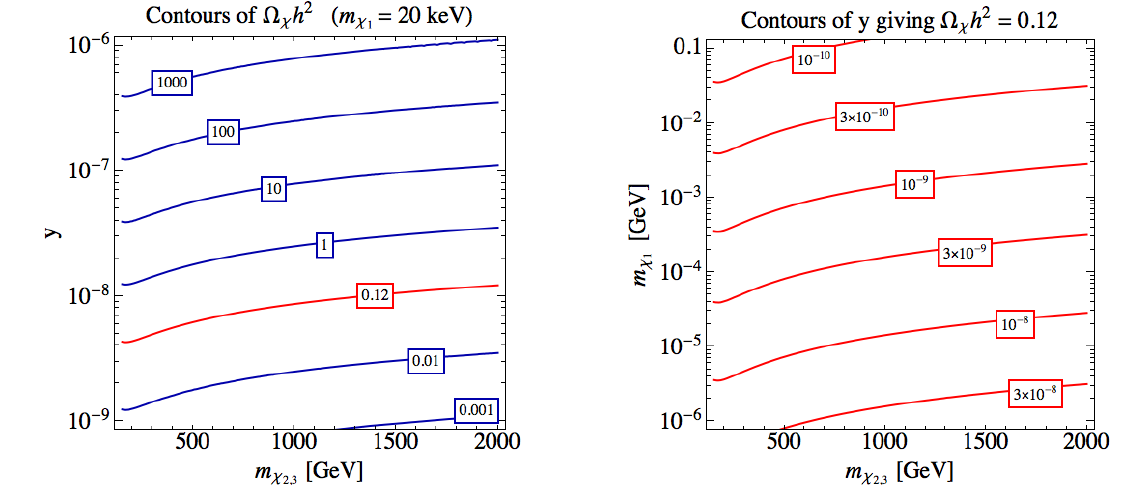
Figure 4 . Left: contours of (cid:10) h 2 for m (cid:31) = m s = 20 keV. Right: contours of the values of y on 1 the ( m (cid:31) ) plane required to get the observed DM relic abundance. ; m (cid:31) 2 ; 3 1 In the left panel of (cid:12)gure 4, we show the dependence of the dark matter abundance through the freeze-in mechanism on the parameters of the model for a (cid:12)xed DM mass = 20 keV on the ( m , y ) plane, or equivalently ( (cid:22) , y ) plane. It appears that, for m (cid:31) (cid:31) 2 ; 3 1 (cid:24) few tens of keV, the coupling should be y = O (10 (cid:0) 8 ) in order to reproduce the m (cid:31) 1 observed dark matter density. In the right panel of (cid:12)gure 4 instead, we show on the ( m , (cid:31) 2 ; 3 2 = 0 : 12. We can see ) plane contours of the values of the coupling y that yield (cid:10) m (cid:31) (cid:31) 1 h 1 that, for m in the [100 MeV, 1 keV] mass range and a (cid:22) scale of relevance for (cid:31) 1